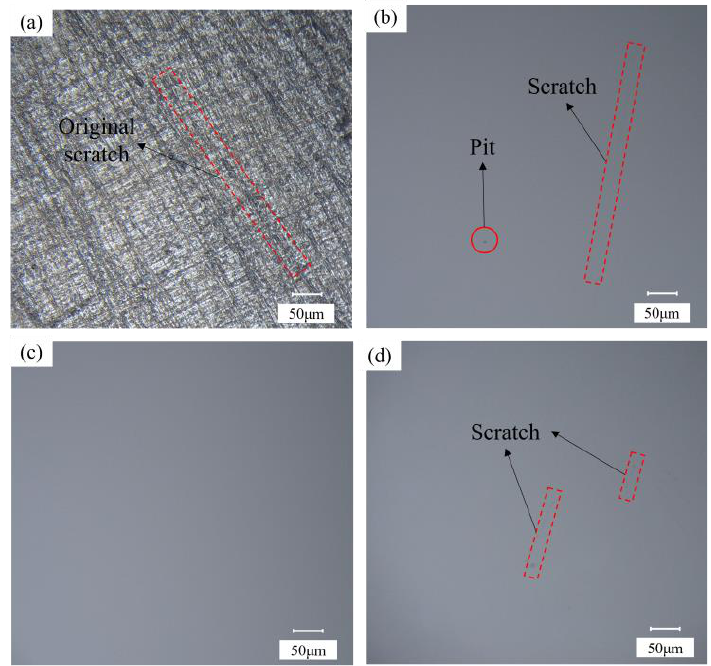
Figure 7. Surface profile of wafer at different polishing speeds: ( a ) original surface, ( b ) 70 r/min, ( c ) 80 r/min, and ( d ) 90 r/min.